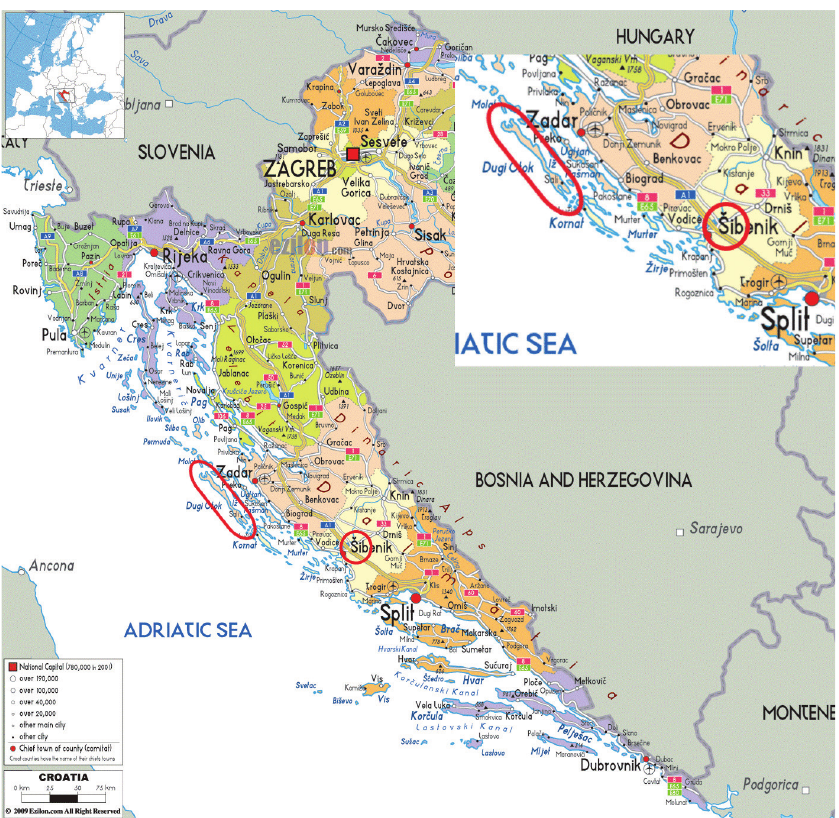
figUre 5. Map of Dendrolimus pini outbreak